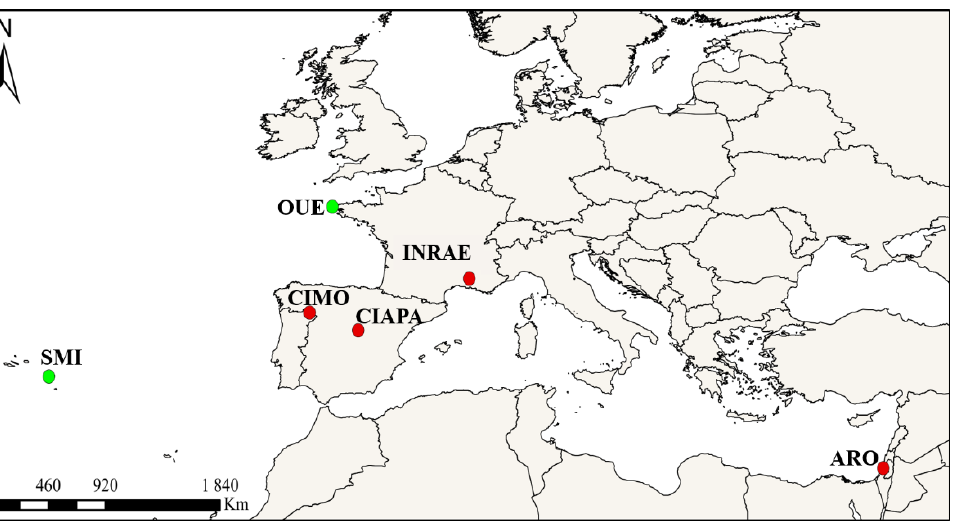
Figure 1. Apiary locations: Bragança, Portugal (CIMO), Fuente la Higuera, Spain (CIAPA), Avignon, France (INRAE), Zrifin, Israel (ARO), Ouessant Island, France (OUE), and São Miguel Island, Azores, Portugal (SMI). Red — V. destructor present, Green — V. destructor absent. Table 1. Location of the apiaries, number of colonies (N = 103) and mitochondrial DNA (MtDNA) lineages of honey bees.